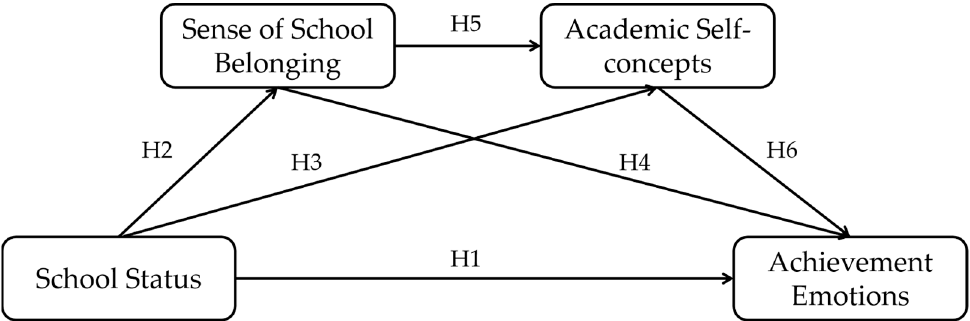
Figure 1. A diagram of our serial mediation